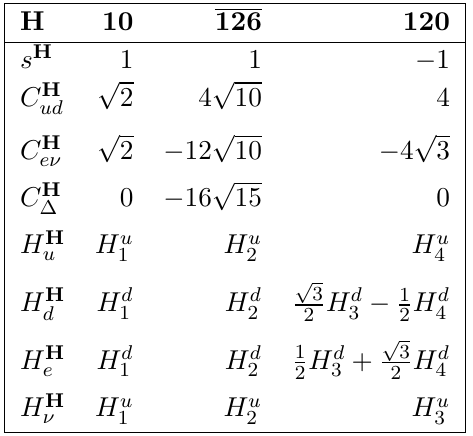
Table 3 . The H -dependent quantities of eq. (2.17) for di(cid:11)erent choices of H